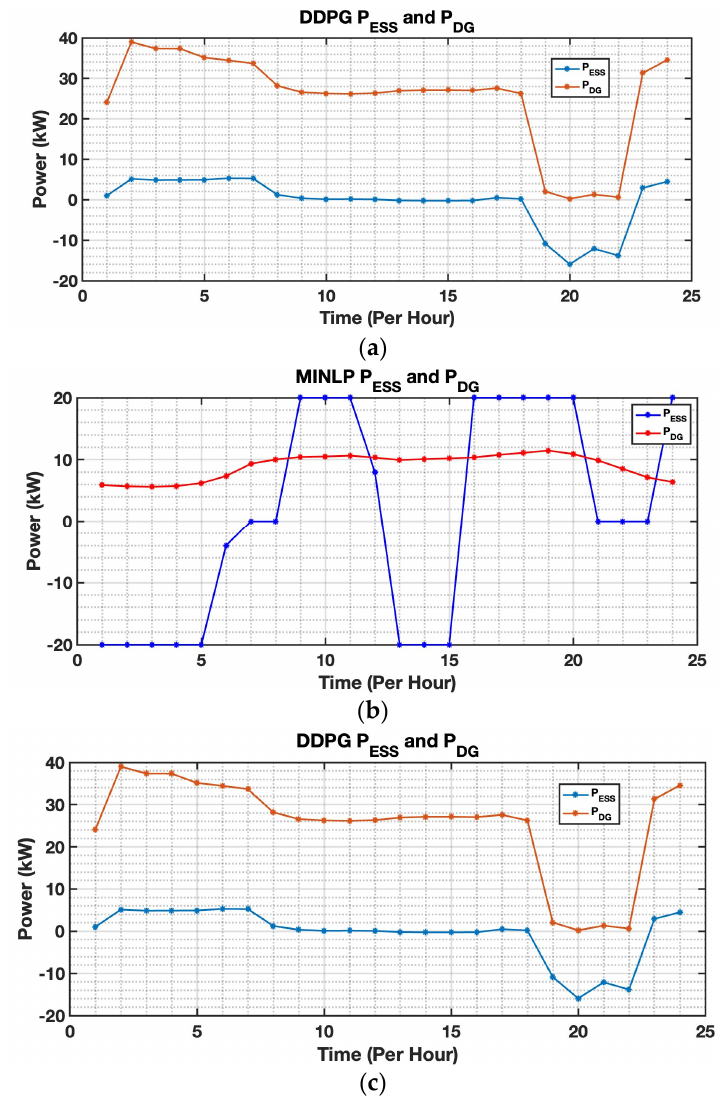
Figure 11. Performance comparison for the BESS and DG output profile: ( a ) DPPG; ( b ) MINLP; and ( c ) GA.